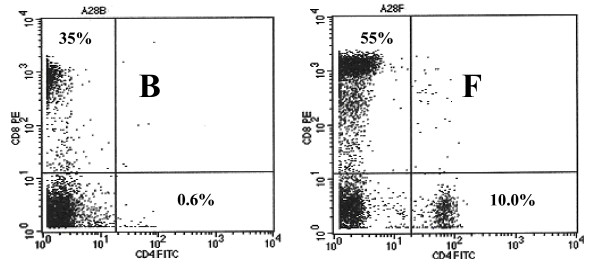
Flowcytometric analysis of CD4/CD8 lymphocytes in patient with low CD4 counts. FL 1 shows FITC labeled CD4+ T lymphocytes. FL 2 shows PE labeled CD8+ T lymphocytes. Note an increase of CD4 + lymphocytes from 0.06% at stage B to 10% at stage F.